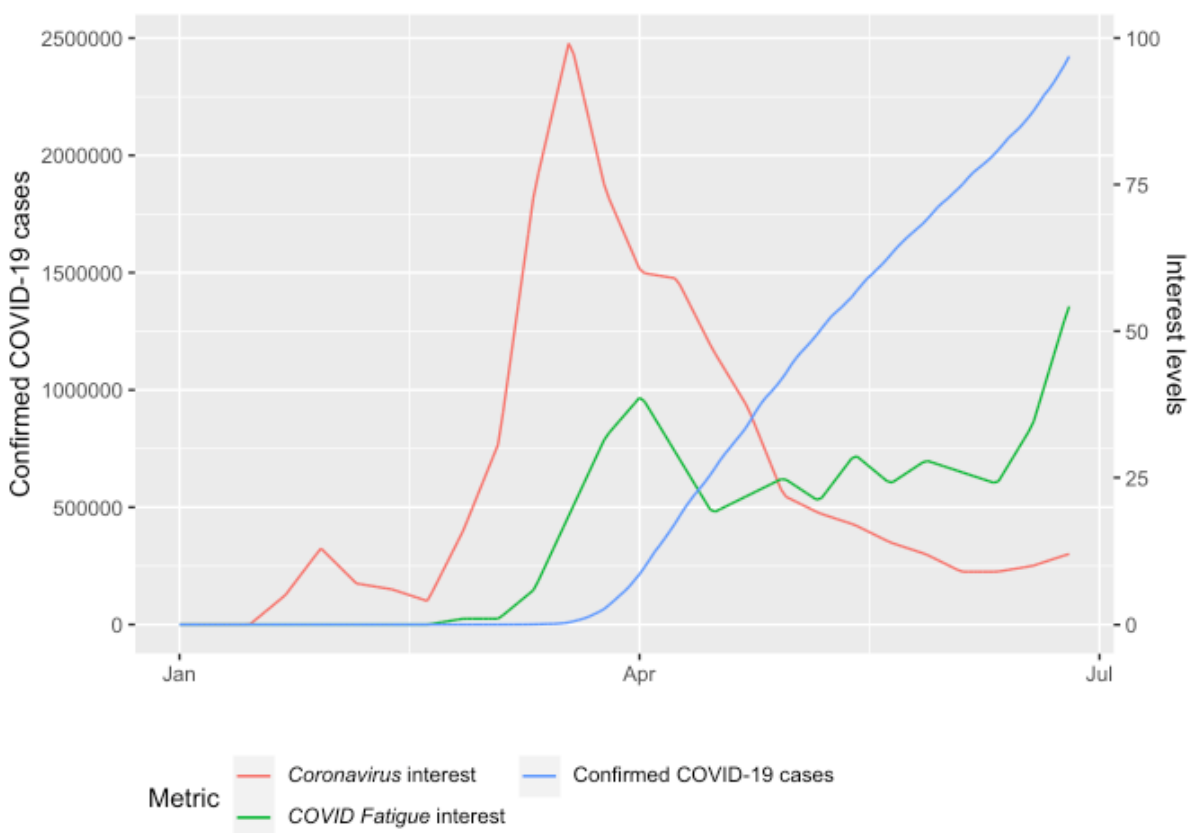
Figure 1. Number of confirmed COVID-19 cases graphed alongside search term interest (scaled from 0-100) during the winter and spring of 2020. COVID-19 case data were taken from the COVID-19 Data Repository by the Center for Systems Science and Engineering (CSSE) at Johns Hopkins University [2]. Search term interest was taken from Google